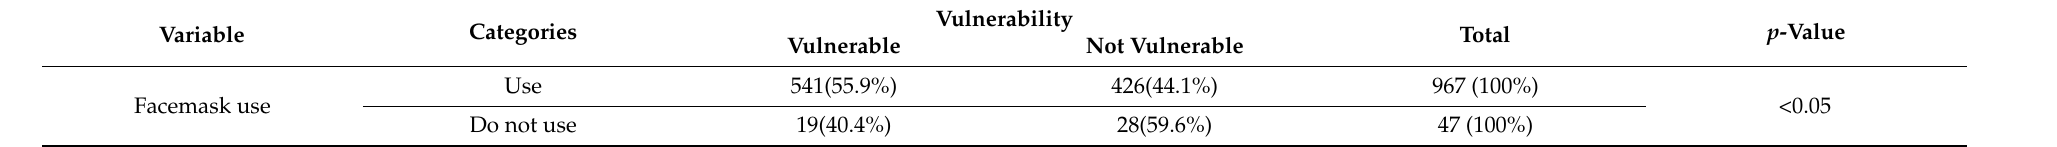
Table 6. Perception of vulnerability and wearing of face mask (N =